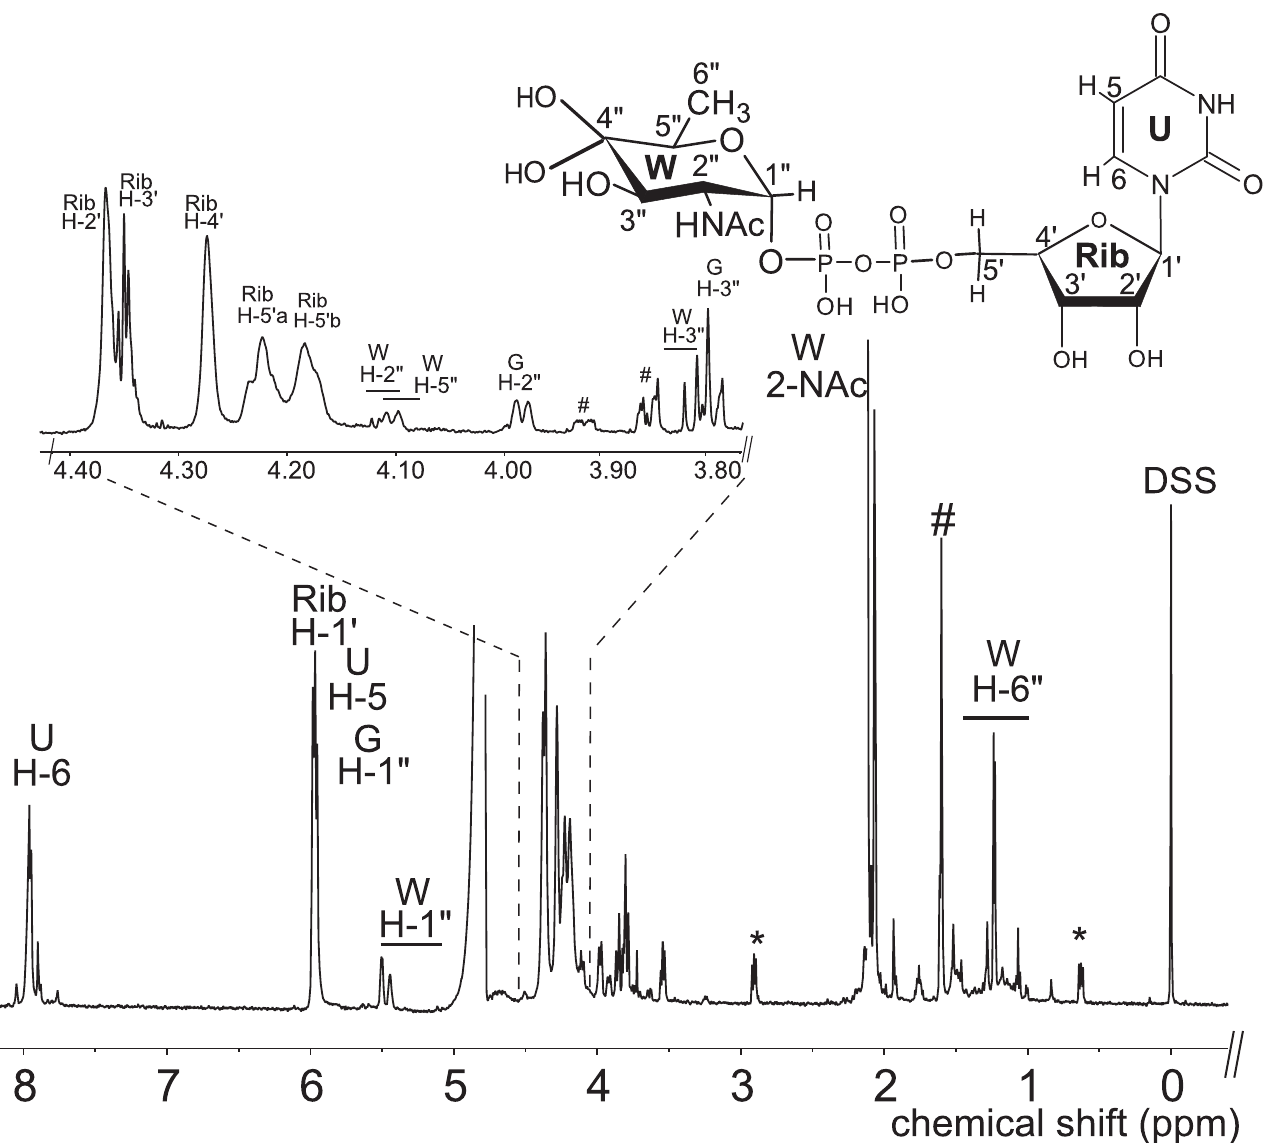
Fig 4. Analysis of Pdeg recombinant enzyme reaction products by 1 H-NMR indicates formation of hydrated-UDP-4-keto-6-deoxyl-D-GlcNAc. The product peak of the Pdeg reaction was collected and analyzed at 600 MHz NMR. Full proton spectrum of the Pdeg product hydrated-UDP-4-keto-6-deoxy- D-GlcNAc. Expanded proton spectra between 3.8 and 4.4 ppm that shows the sugar ring. The short line above NMR ‘ peaks ’ denotes specific chemical shifts belonging to a UDP-4-keto-6-deoxy-D-GlcNAc. Symbol(#) denotes column contamination and symbol ( * ) denotes